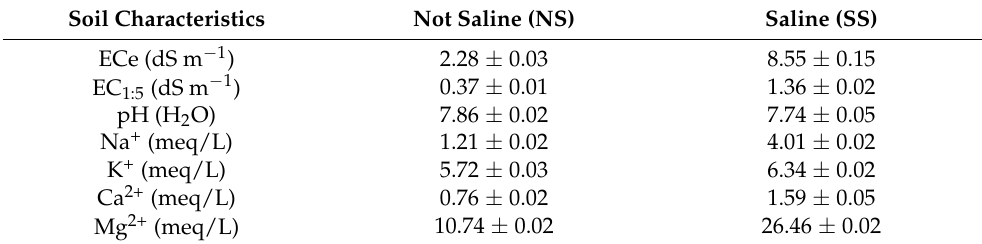
Table 1. Physicochemical characterisation of the soil before starting the treatments. The mean values ± SE ( n = 3) are shown for each soil parameter. Soil